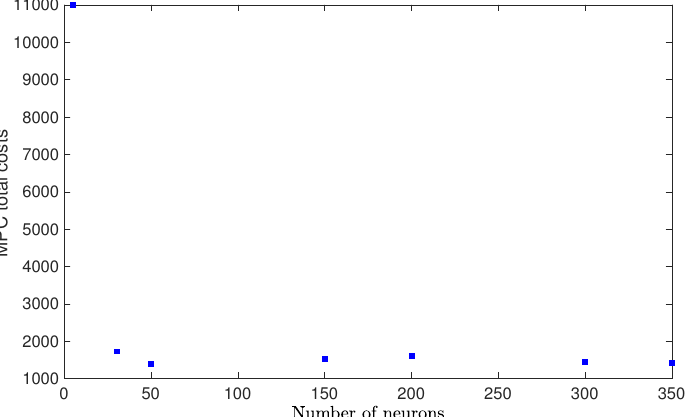
Figure 14. MPC total costs vs. RNN width.